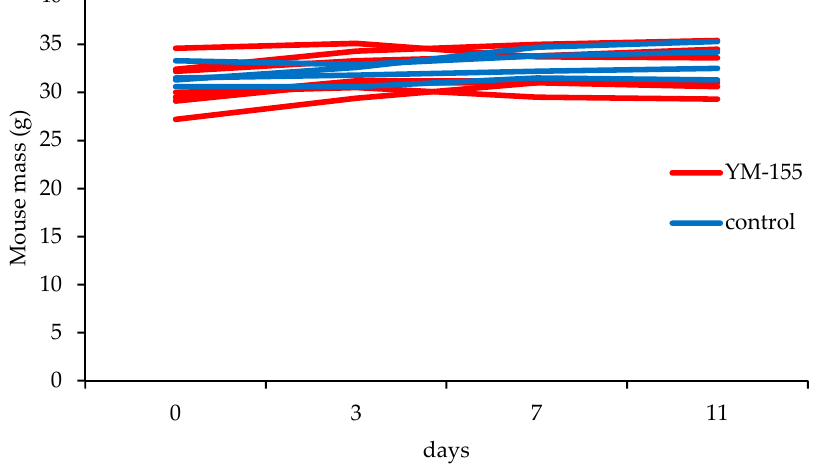
Figure A2. Weight changes in mice during the 11 days of YM155 treatment or control. No observable differences were seen for any individual mouse or between treatment groups.